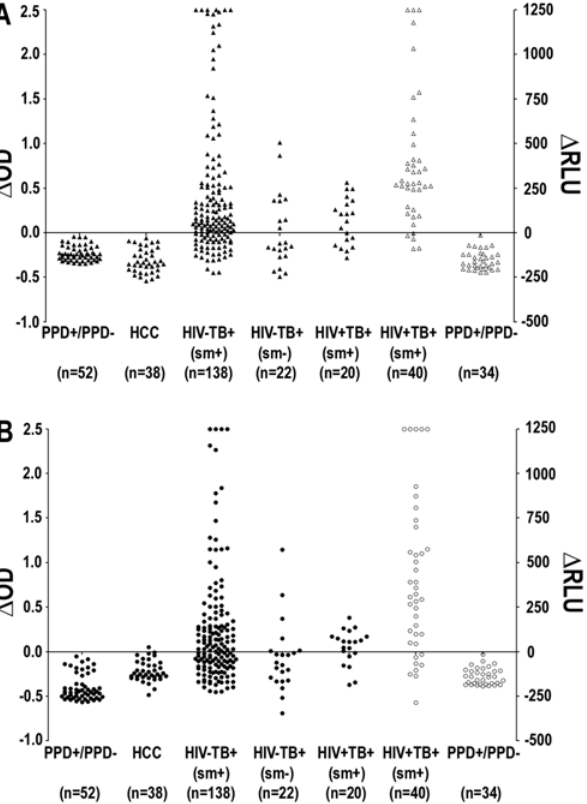
Figure 2. Presence of anti-MS or anti-MPT51 antibodies in TB patients: Sera from healthy PPD + /PPD 2 subjects, healthy community controls (HCC) and TB patients was tested for presence of anti-MS (A) or anti-MPT51 (B) antibodies. Delta OD (optical density) represents the OD obtained with the individual serum specimen minus the mean OD plus 3 standard deviations obtained with the PPD + /PPD 2 healthy subjects. Filled symbols represent results from ELISA assays in which the Invitrogen substrate was used. Delta RLU (relative light units) represents relative light units obtained with the individual serum specimen minus the mean RLU plus 3 standard deviations obtained with sera from PPD + / PPD 2 healthy subjects. Hollow symbols indicate results from ELISA assays in which the PhosphoGLO AP substrate was used. Numbers in parenthesis indicate number of subjects in each group.